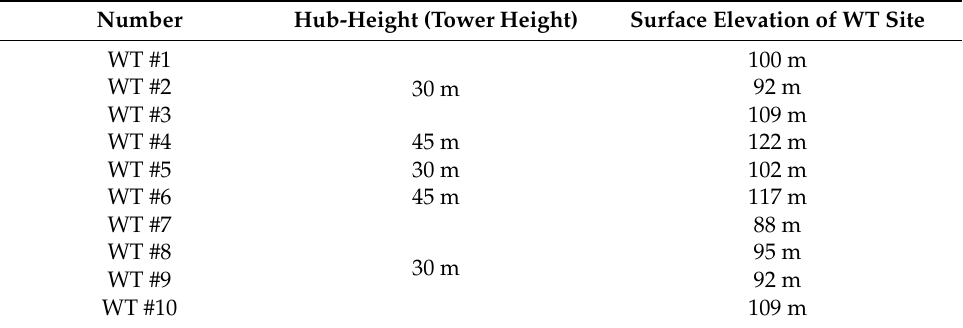
Table 2. WT hub-heights and surface elevations.